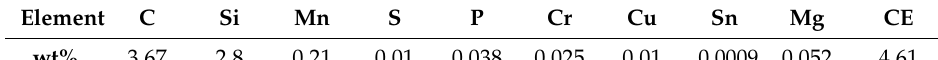
Table 1. Average chemical composition of the molten alloy (values in weight percentage).